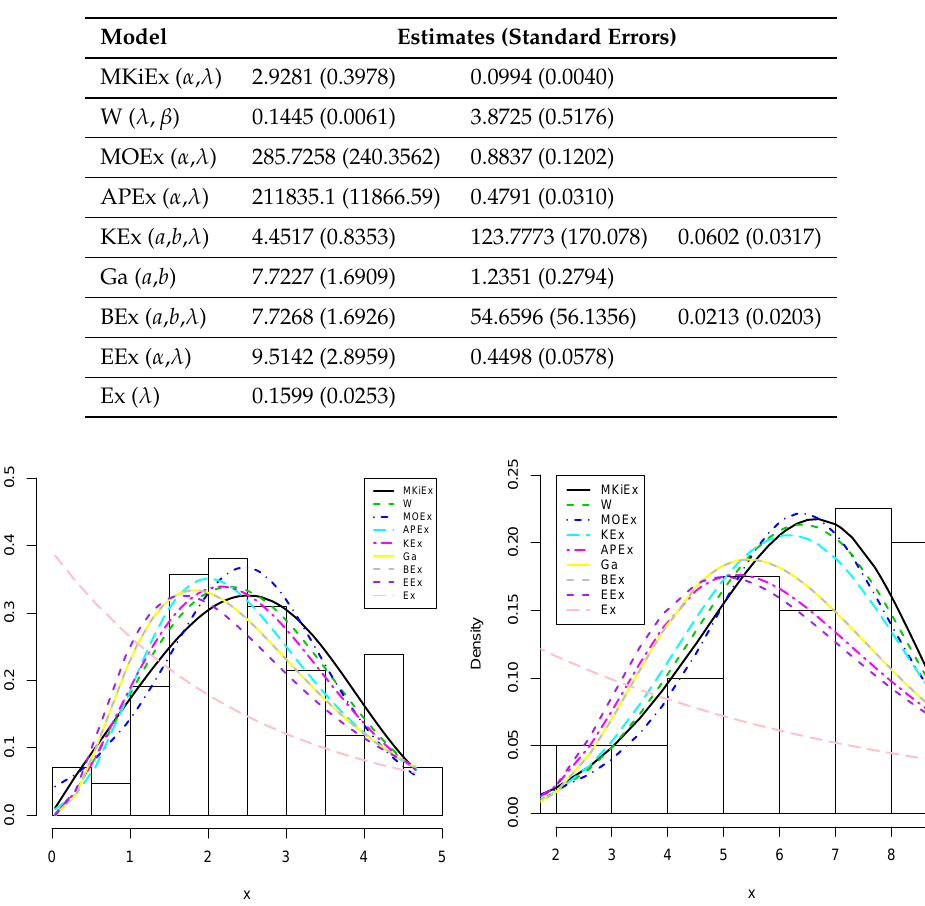
Figure 5. Fitted densities for data I ( left ) and data II ( right ).